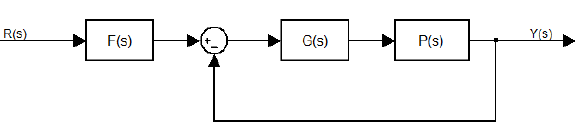
Figure 8. Structure of a two-degree of freedom